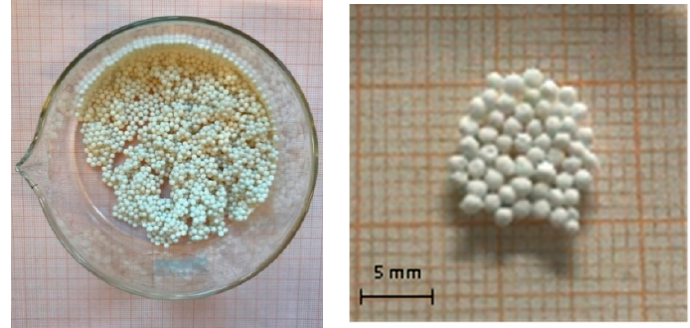
Figure 6. Li 4 SiO 4 pebbles obtained by the drip casting process at DICI laboratory.